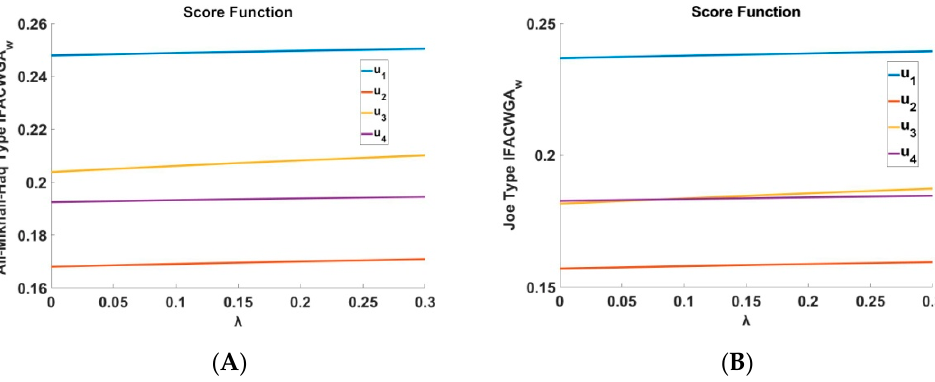
IFACWGA score result. ( B ) Clayton-type w